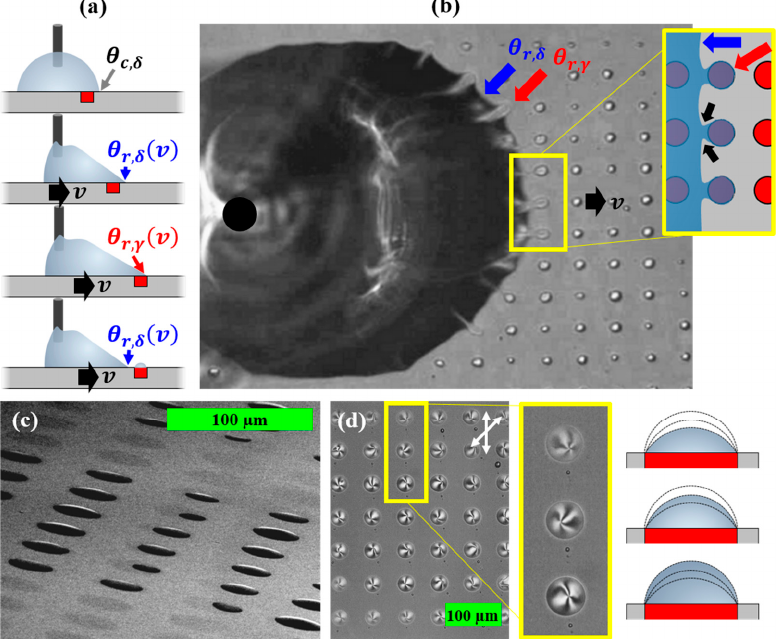
Figure 2. Dragged-drop method used to generate LC arrays. ( a ) A schematic method where the syringe is kept stationary while the chemically-patterned surface is moving to the right, causing droplets to form on the right edge of the large drop. Blue and red arrows show the receding contact angle on the LC-phobic and LC-philic region, respectively. ( b ) An image of the droplet nucleation process taken on a custom microscope. Yellow inset shows droplets pinching off of the larger drop. ( c ) ESEM image of liquid crystal droplets on a chemically patterned surface after individual passes using the dragged-drop method. Droplets are contained on the dark regions on the surface, which indicate the oxygen content of the MDA ink. More images are included in the Supplementary Material Figure S3. ( d ) A POM image of the droplet array after a single pass. White arrows show the orientation of the polarizer and analyzer. The yellow inset highlights the difference in droplet size between the center and the periphery of the dragged-drop, schematically shown on the